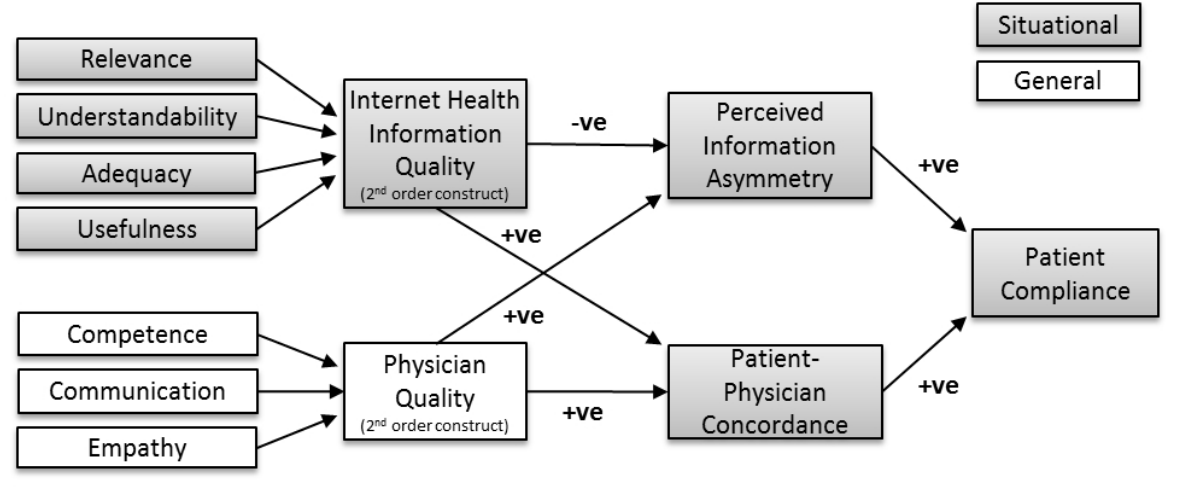
Figure 1. Research